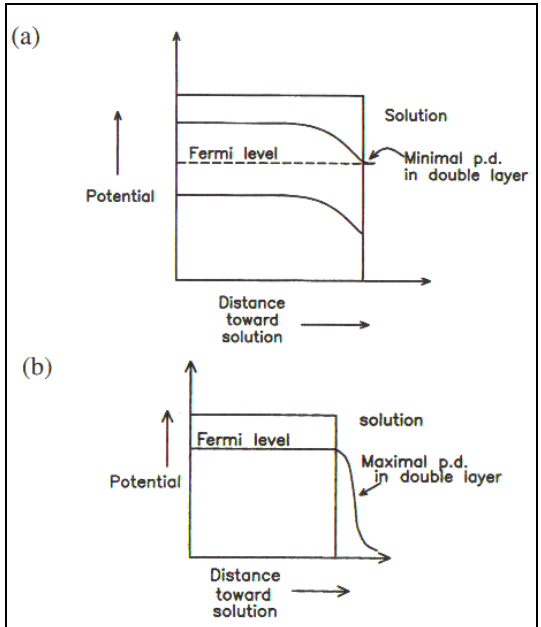
Figure 4. ( a ) The semiconductor/solution interface (no surface states); ( b ) The metal/solution interface (Reprint from